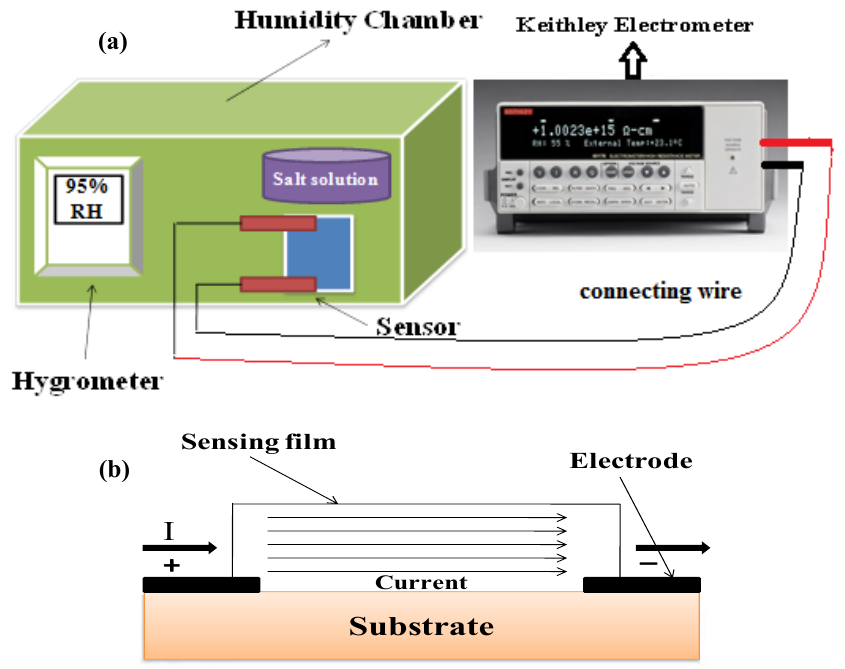
Fig. 1. (a) Device assembly for humidity detection and (b) Schematic of sensing